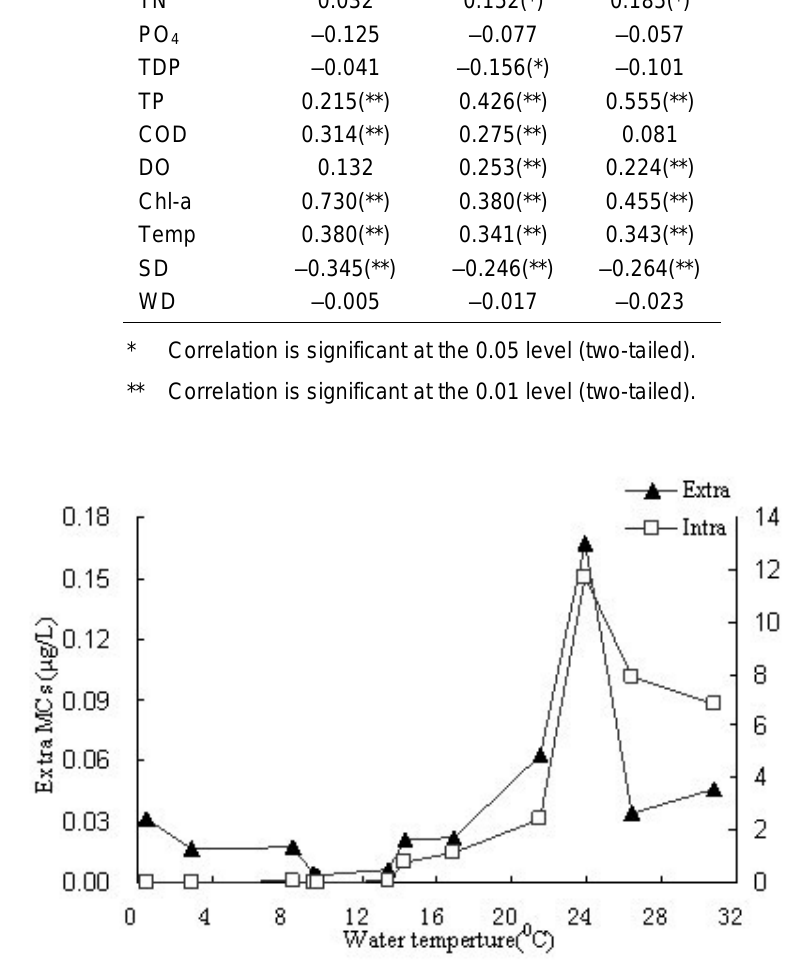
FIGURE 8. Relationship between water temperature and intra- or extracellular